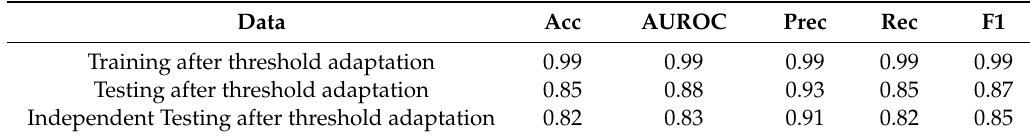
Table 2. Performance metrics on the same training and testing sets after updating the prediction thresholds, and evaluated using the metrics accuracy (Acc), AUROC, precision (Prec), recall (Rec) and F1-score (F1).